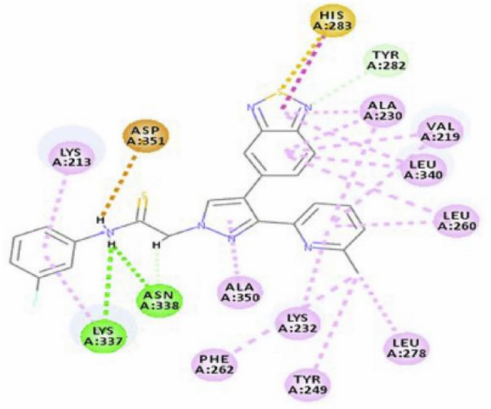
Figure 91. Two-dimensional putative binding interactions of compound 82 with ALK5 crystal structure